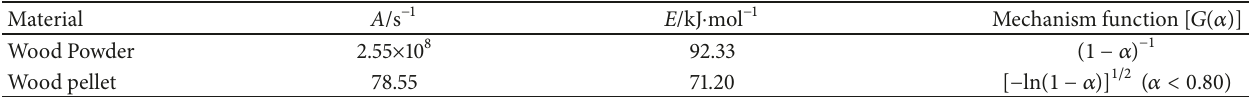
Table 5: Kinetic triplets of wood powder and pellet.